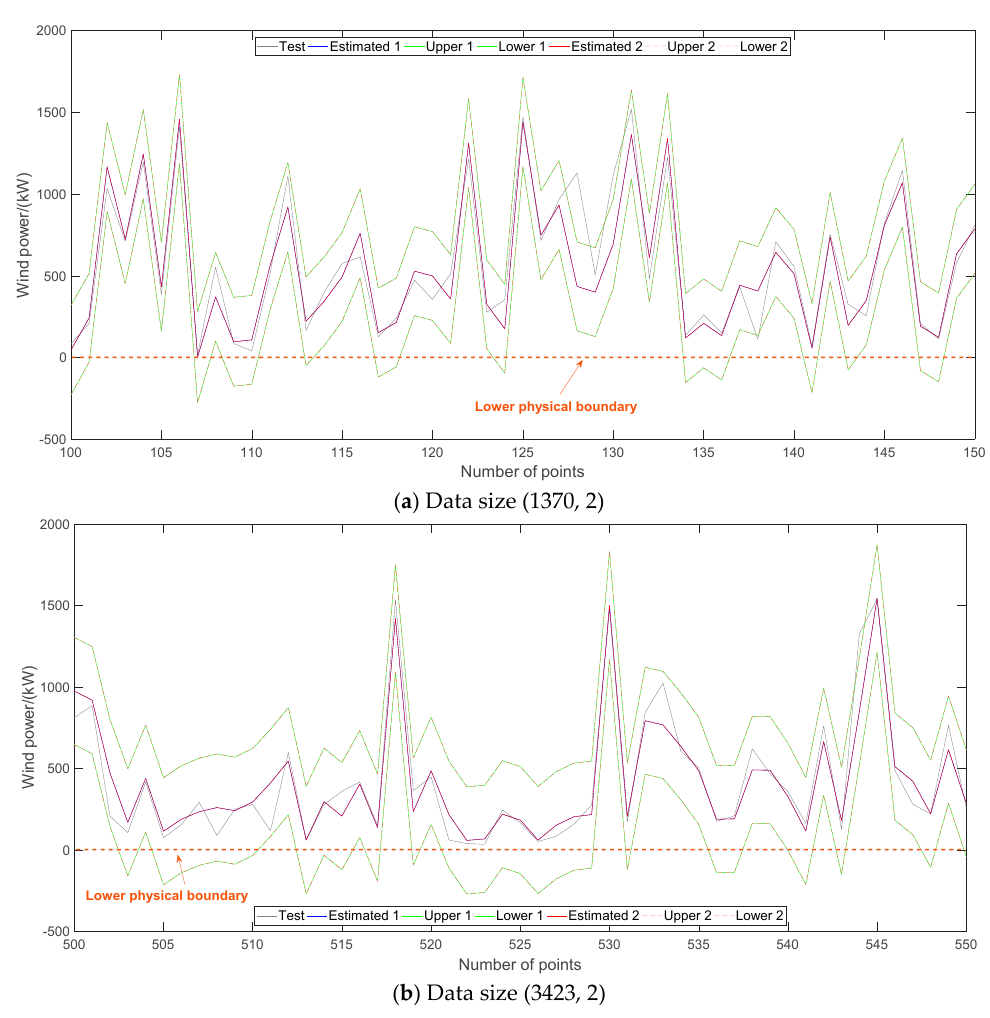
Figure 8. Comparison of WTPC output using different objectives for data size (3423, 2).